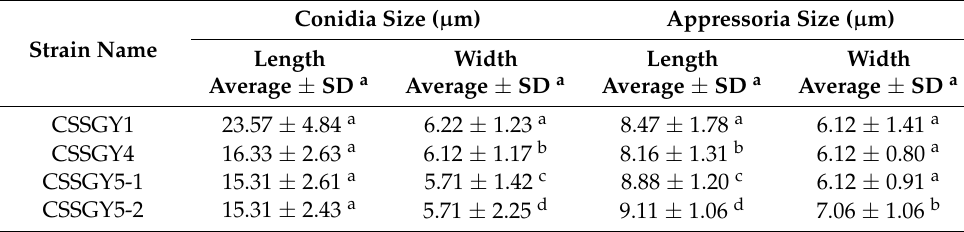
Figure 2. Morphological characteristics of colonies, conidia, and appressoria of the Colletotrichum isolates isolated from luffa sponge gourd. ( A ) Colony morphology of the positive sides of the fungal strains CSSGY4, CSSGY1, CSSGY5-1, and CSSGY5-2 cultured on potato dextrose agar (PDA). ( B ) Reverse sides on PDA. ( C ) Microscopic examination of the conidia. ( D ) Microscopic examination of the appressoria. Scale bar = 100 μm. Table 2. Morphological characteristics of Colletotrichum strains isolated from luffa sponge gourd.